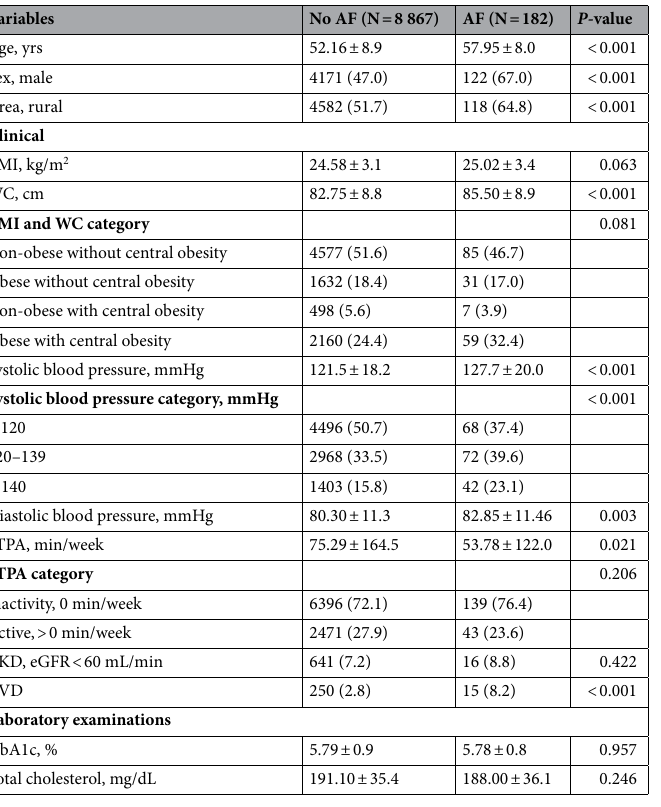
Table 1. Baseline characteristics of study population (n = 9094). Continuous variables are reported as mean ± standard deviation, and categorical variables are reported as n (%). AF, atrial fibrillation; BMI,